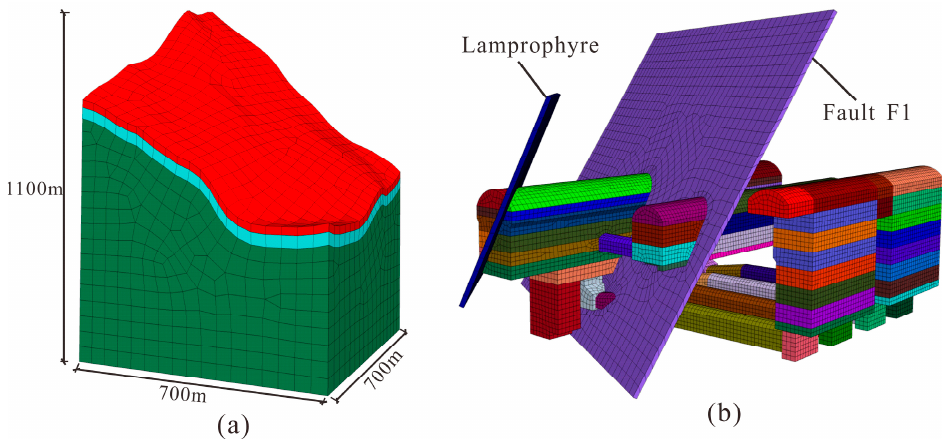
Figure 5. Numerical model for the in situ stress inversion. Mesh model of the surrounding mountain ( a ) and underground cavern and main geological structures ( b ). Table 4. Boundary condition scheme L 49 (7 6